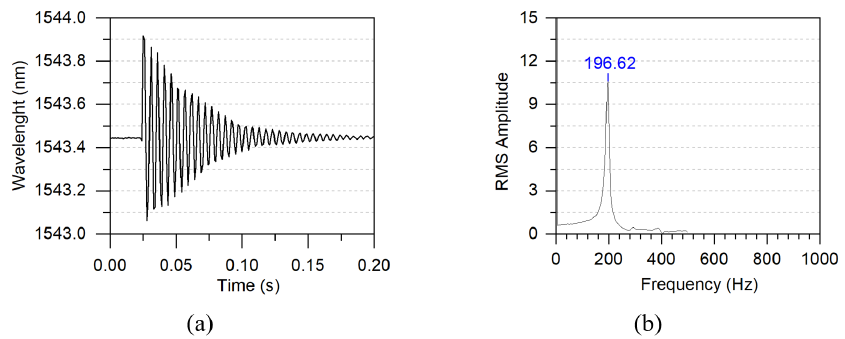
Figure 12. FBG signal in (a) time and (b) frequency domain